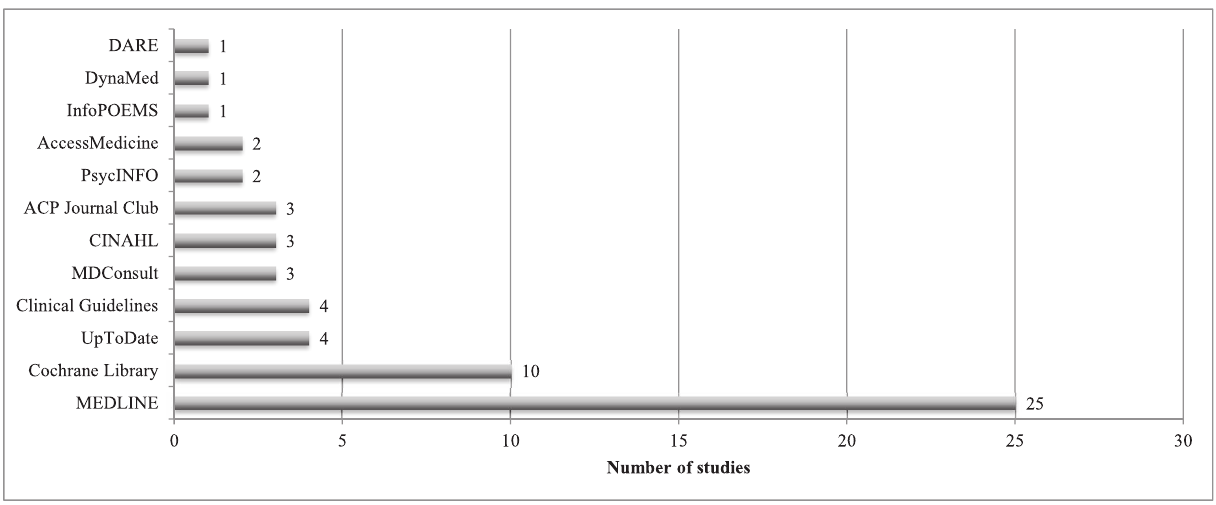
Figure 2 Frequency distribution of resources taught in evidence-based practice * Studies referencing the sources shown: DARE [32]; DynaMed [20]; InfoPOEMS [25]; AccessMedicine [20, 25]; PsycINFO [20, 24]; ACP Journal Club [32, 35, 39]; CINAHL [24, 39, 40]; MDConsult [22, 25, 39]; Clinical Guidelines [20, 22, 29, 38]; UpToDate [20, 32, 35, 39]; Cochrane Library [19, 20, 24, 25, 29, 32, 34, 35, 38, 39]; MEDLINE [14–17, 19–25,